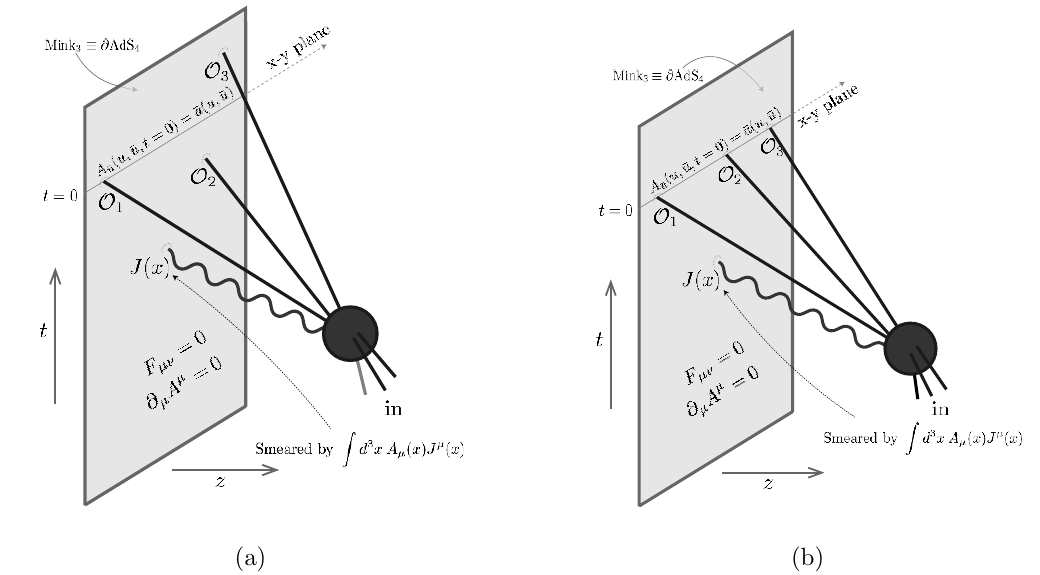
Figure 2. Typical @ AdS 4 correlators involving 4D photons and matter particles, dual to CFT 3 correlators of the form eq. (5.9) involving the U(1) current and other local operators. (a) corresponds to charged matter lines arriving at general times on the boundary, while (b) corresponds to the special case in which all charged matter arrives at t =